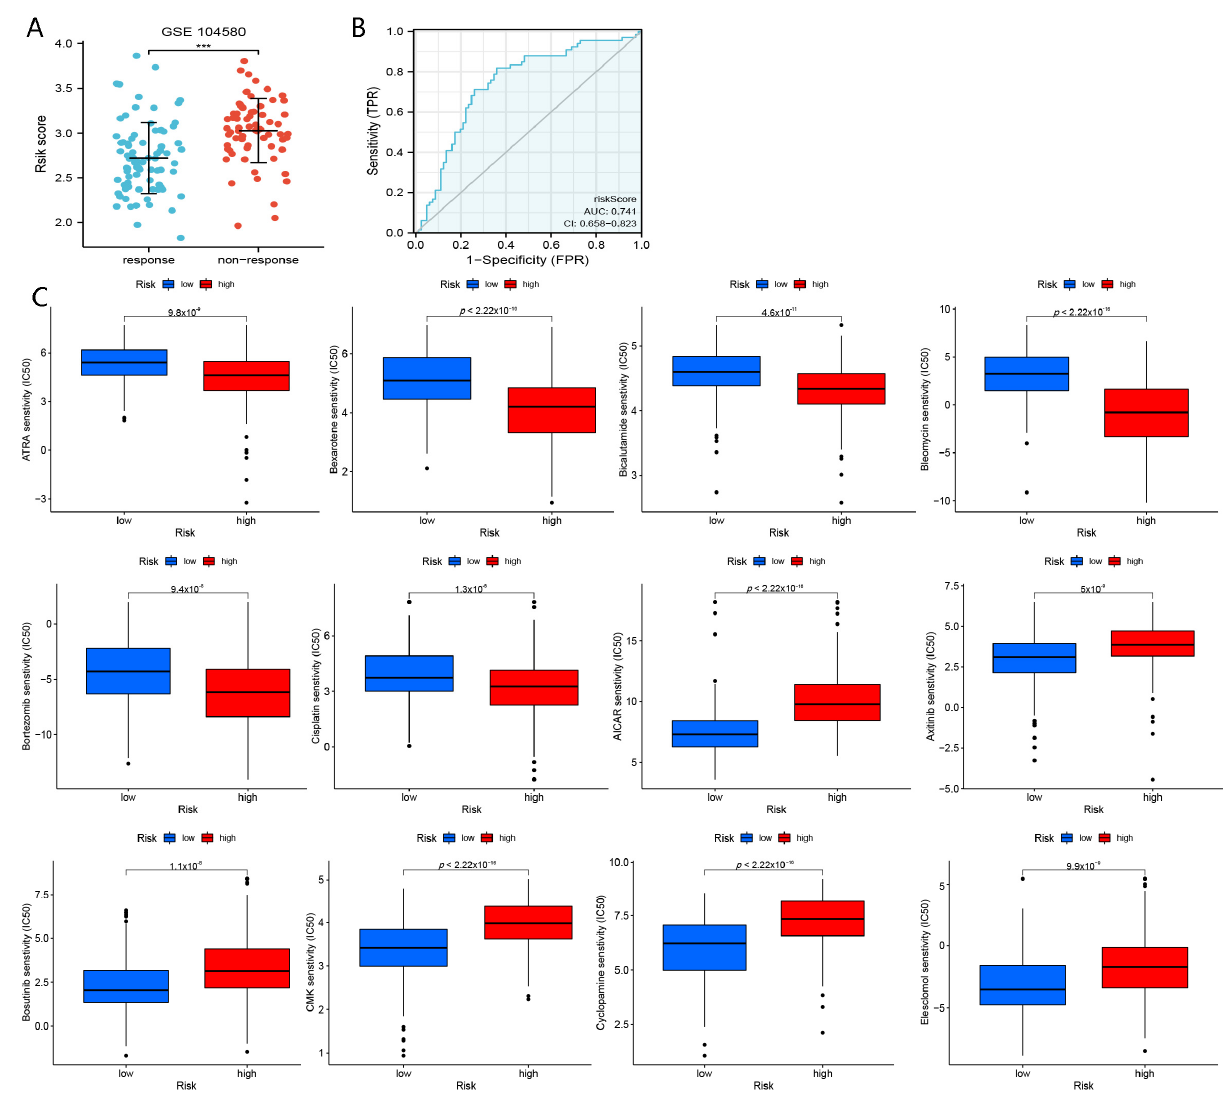
Figure 12. Analyses of response to TACE and drug sensitivity. ( A ) Comparison of risk scores in responders and non-responders to immunotherapy. ( B ) ROC curve of nFRGs evaluating the response to TACE. ( C ) Screening of sensitive drugs for the high- and low-risk groups. (*** representing p < 0.001).